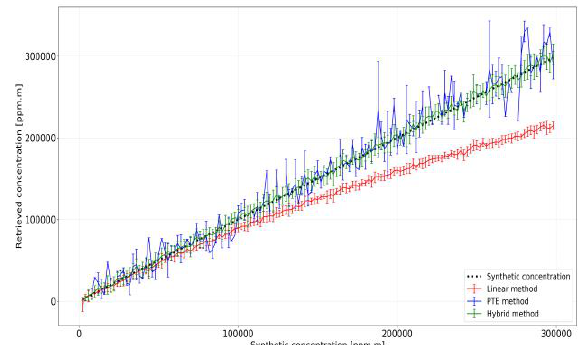
Figure 7 . Retrieved concentrations for the three